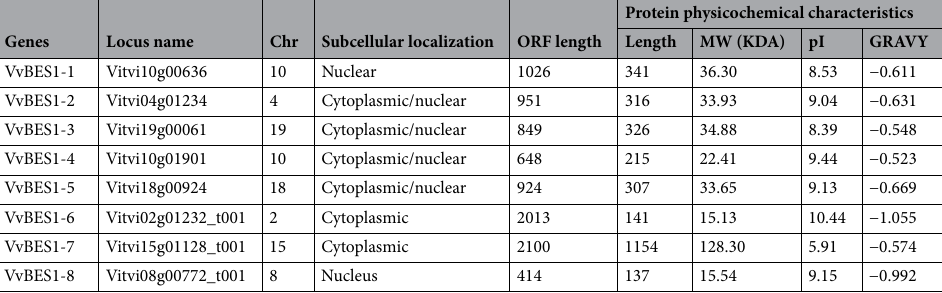
Table 1. The characteristic of BZR1/BES1 genes from grape.